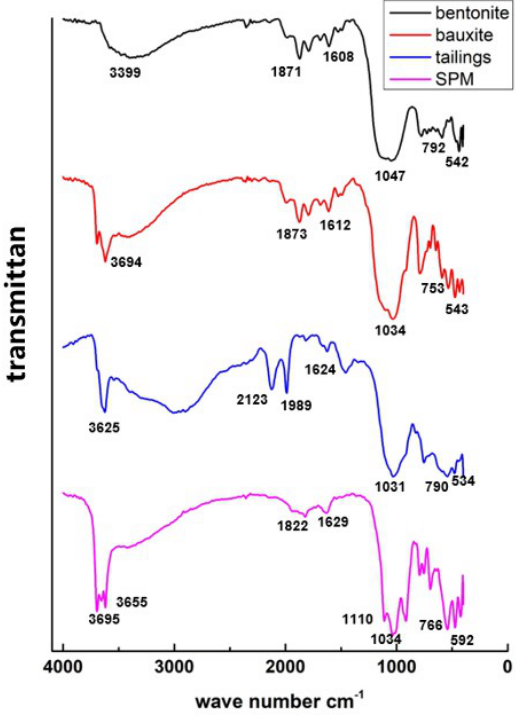
Figure 3. Fourier transform infrared (FTIR) spectra of SPM, silicate tailings, bauxite, and bentonite.